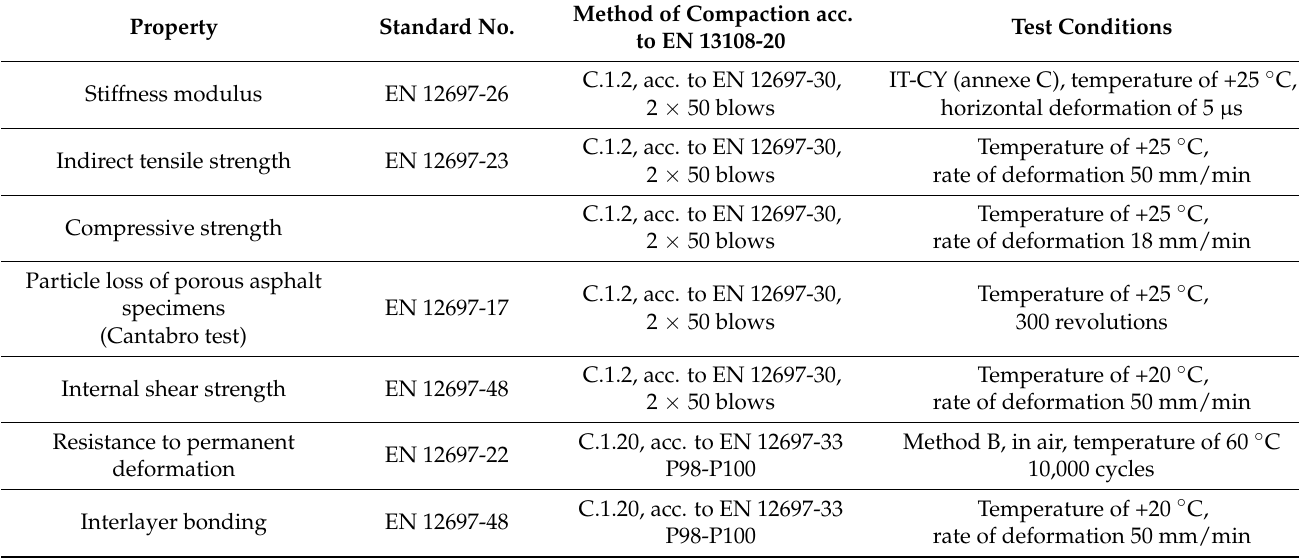
Table 4. Summary of laboratory test